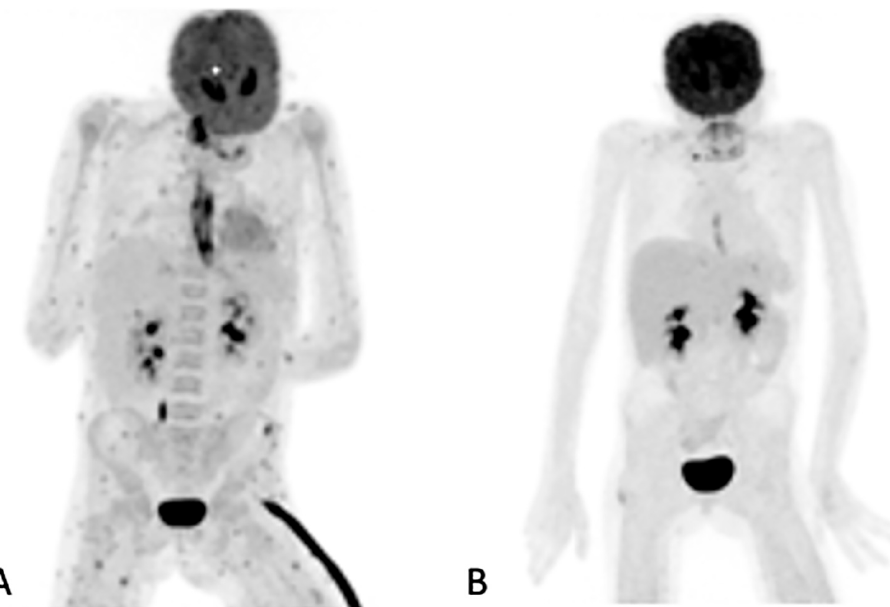
Figure 2. Maximum intensity projection (MIP) of [ 18 F]FDG images of a 10-year-old girl on chemother- apy for acute lymphocytic leukemia. She had a persistent fever unresponsive to antibiotics. HR CT not shown (was unremarkable). The initial study ( A ) revealed widespread, multiple, small, metabolically active foci in the muscles and esophagitis, which were later found to be due to Candida dubliniesis upon biopsy. The lesions were not detected by the corresponding CT of the [ 18 F]FDG PET/CT study. A follow-up [ 18 F]FDGPET/CT study ( B ) after 6 weeks of antifungal treatment showed a very good metabolic response, with a single residual focus in the right gluteus and the resolution of the esophagitis. No anatomy-based study was performed together with the follow-up [ 18 F]FDG PET/CT study ( B